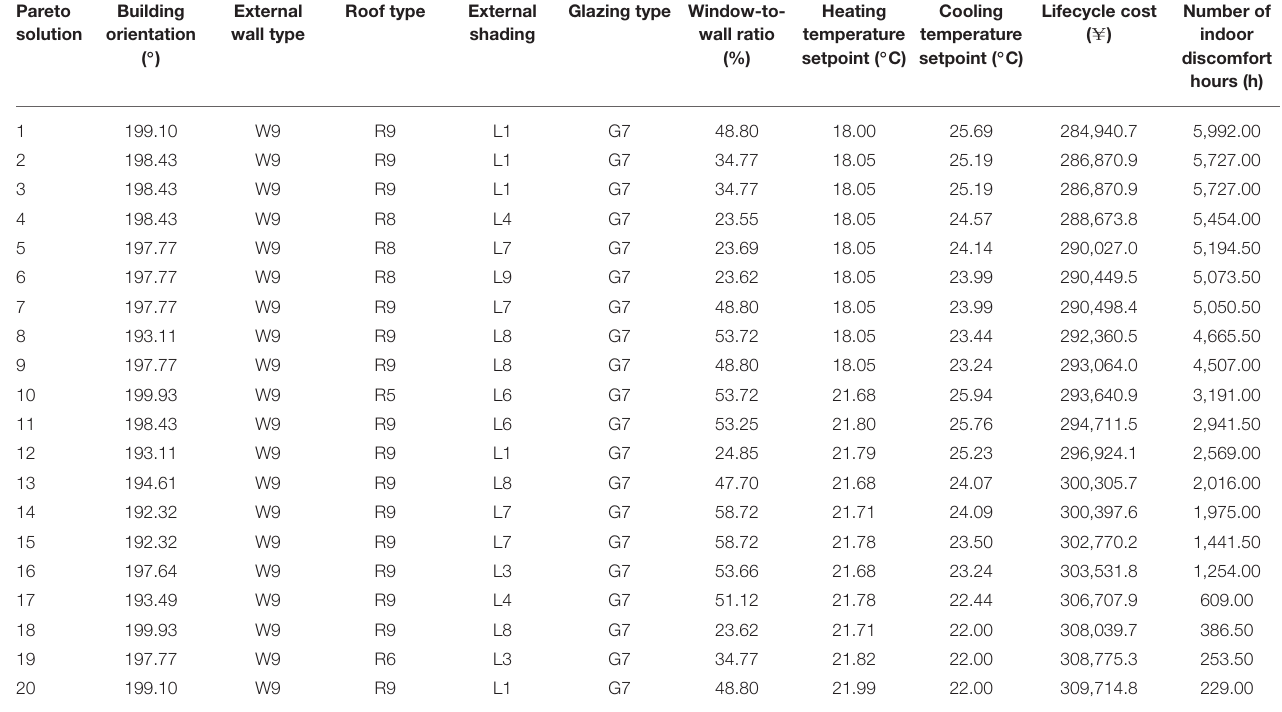
TABLE 10 | 20 sets of Pareto solutions randomly selected for Chengdu considering the trade-offs between life cycle cost and number of indoor discomfort hours. Pareto